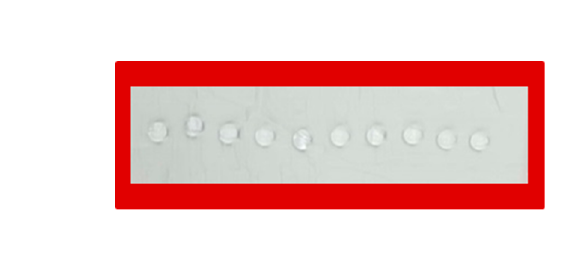
µ L) deposited on the TiO